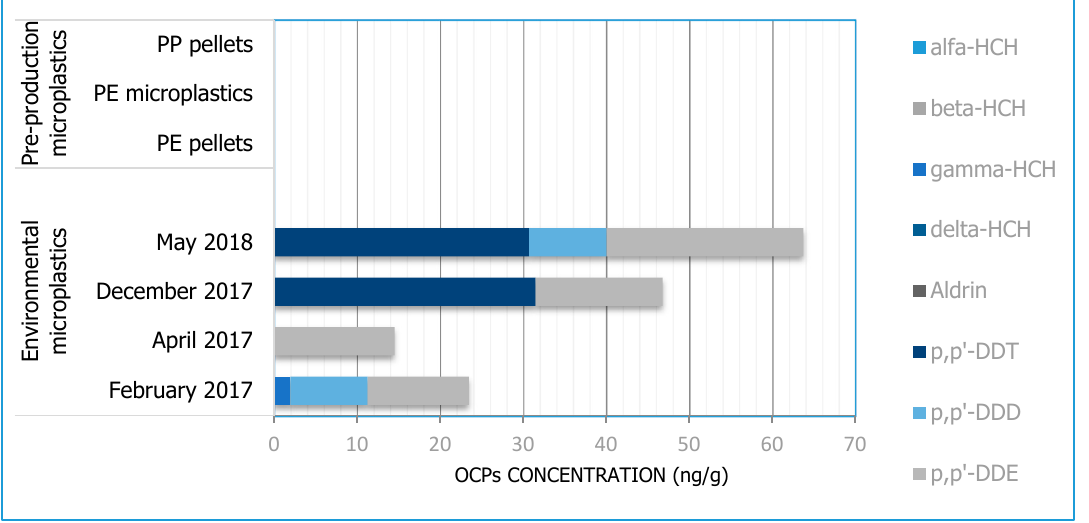
Figure 4. Concentrations of eight organochlorine pesticides (OCPs), expressed as ng/g, registered on environmental MPs (April 2017, February 2017, December 2017, May 2018), and on virgin MPs (virgin PE, virgin coloured PE, virgin PP). Virgin PE and PP were colourless pellets while virgin coloured PE was green microparticles (<500 μ m).